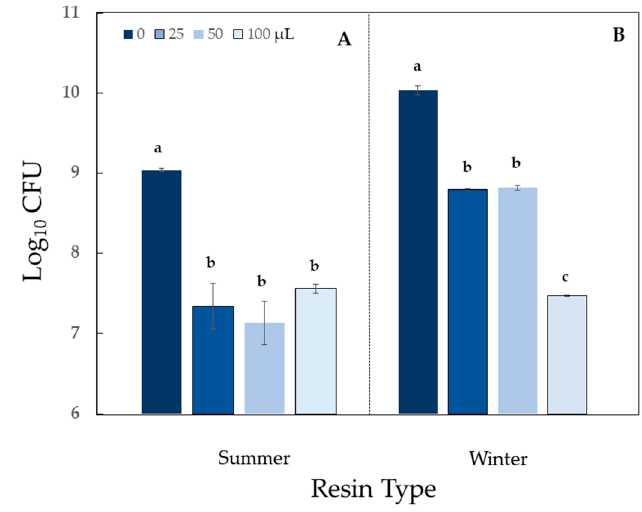
Figure 6. Antimicrobial activity of autoclaved Sv resin against Bacillus cereus . Resins collected in ( A ) summer or ( B ) in winter were tested within 72 h. Treatment doses (0, 25, 50, and 100) are volumes of suspended resin ( μ L) in 300 μ L. For each resin type, bars appearing with the same letter are not different according to Tukey’s test ( P < 0.05). Data shown are arithmetic means + standard errors.